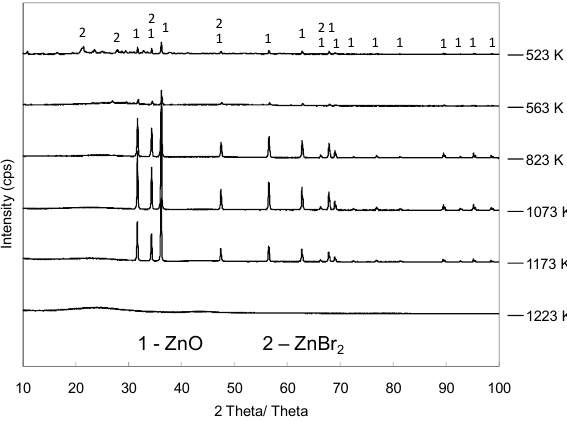
Figure 4. XRD patterns of the residues from isothermal treatment of TBBPA:ZnO (3.34:1) at Argon atmosphere for 40